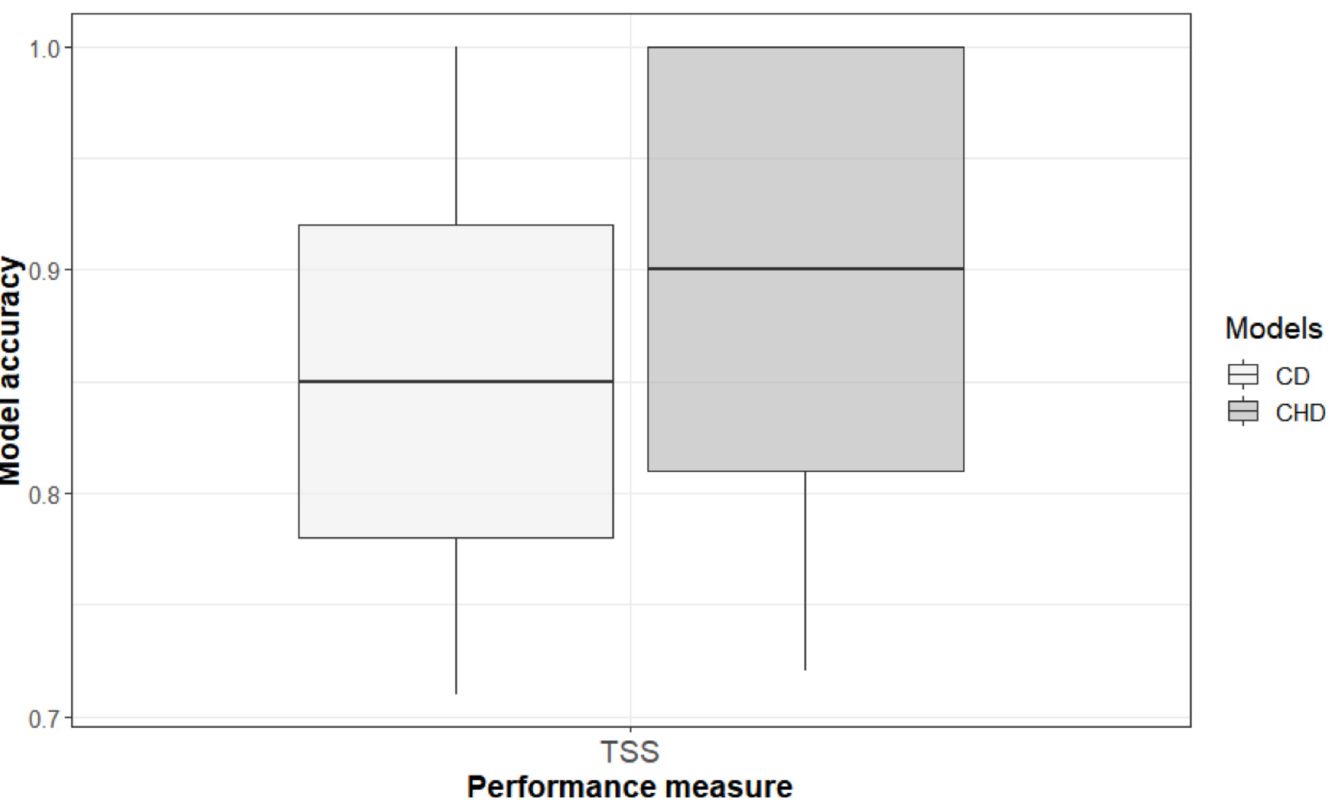
Fig 2. TSS values for the climate-driven model and combined model (climate and human activity index).